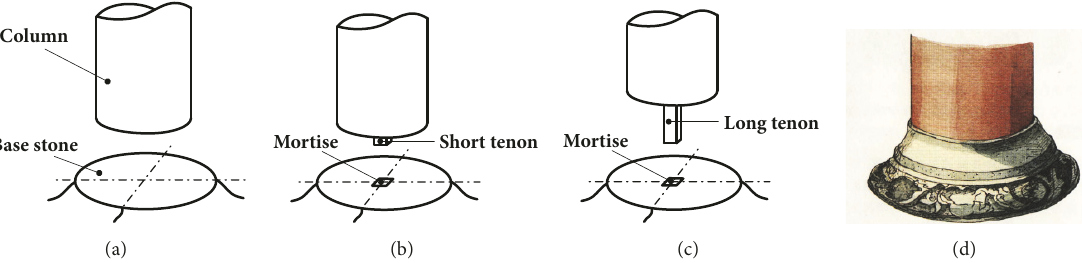
Figure 2: Different forms of Chinese-type CFJ: (a) Floating; (b) Guan-jiao; (c) Tao-ding; (d) appearance.